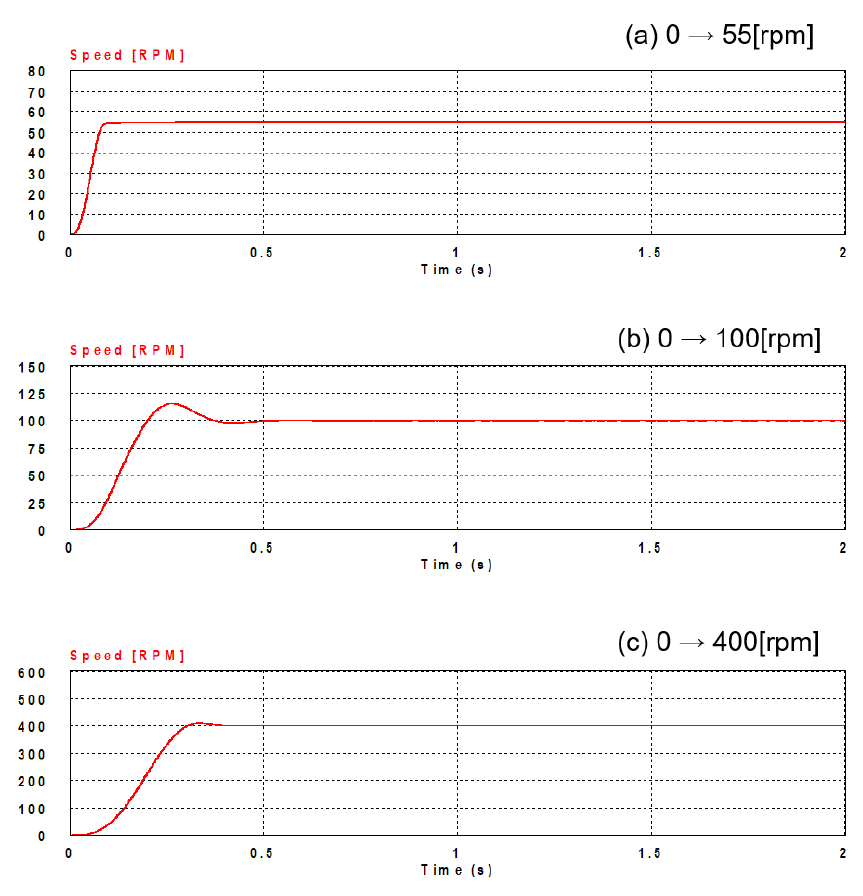
Figure A4. Velocity step response characteristics.